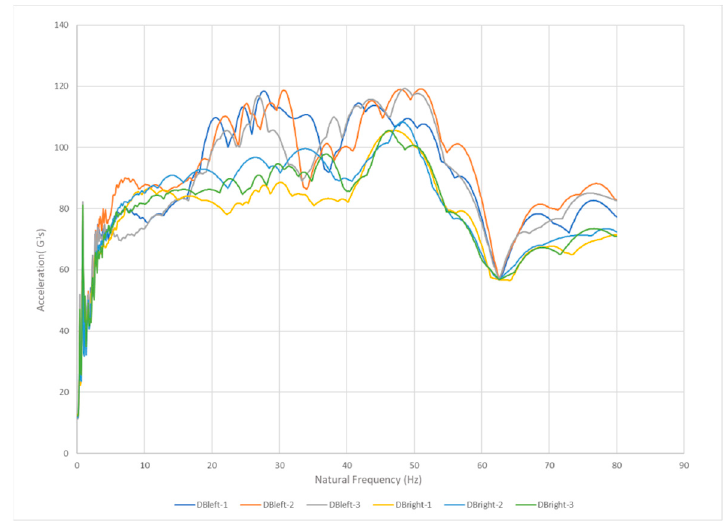
Figure 9. Example of SRS results for one CrossFit athlete extracted for three runs on both feet.